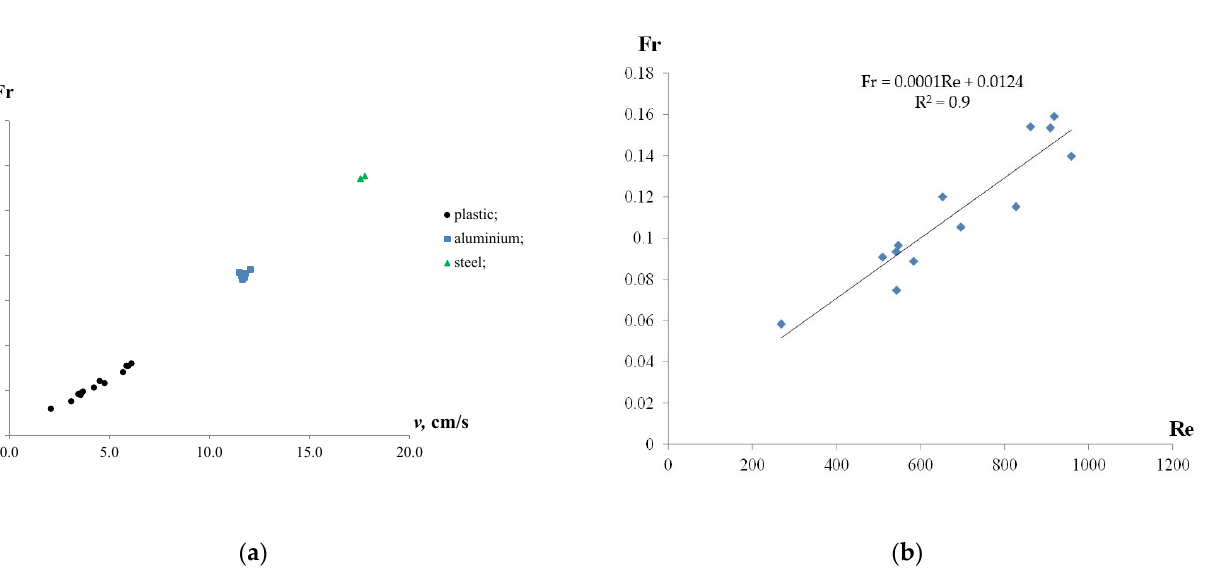
Figure 7. Froude number as a function of velocity of the particles ( a ) and Reynolds number ( b